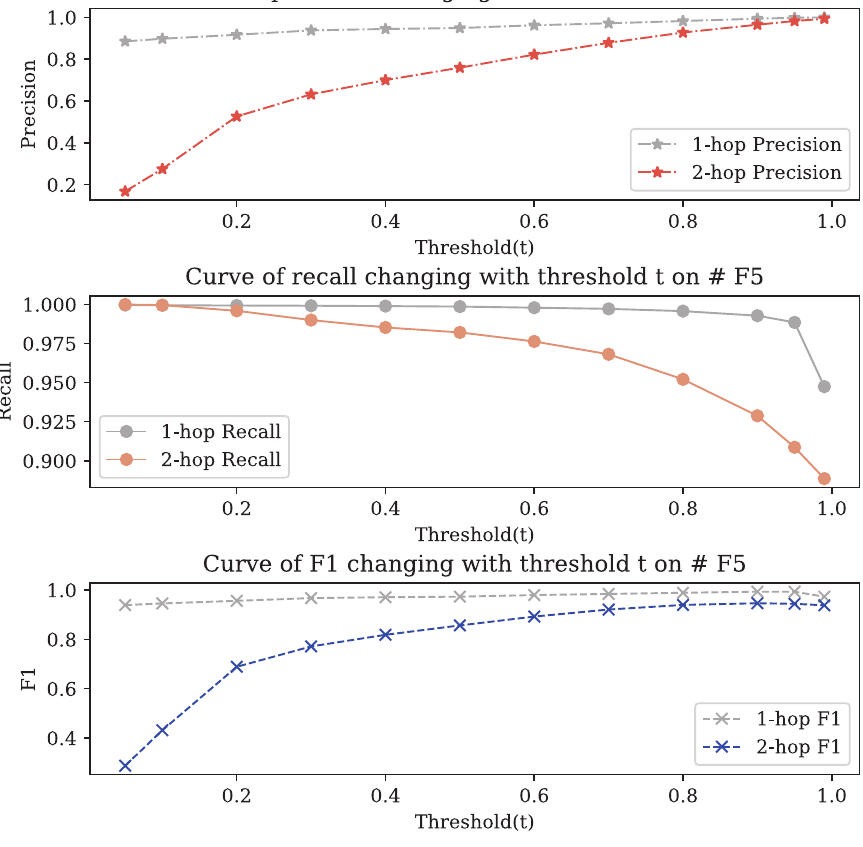
Figure 5. Curve of precision , recall and F 1 of the CFR changing with threshold( t ) on 1-hop and 2-hop